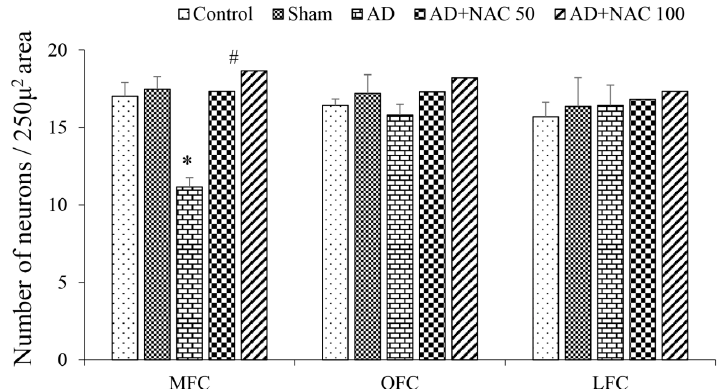
Figure 4. Quantitative estimation of normal neurons in prefrontal cortex. The number of neurons in 250 µ 2 area was quantified. Values are expressed as mean ± SE. Control/sham vs. AD: *, p < 0.01; AD vs. AD + NAC 50 or AD vs. AD + NAC 100: #, p < 0.01 (One-way ANOVA, Bonferroni’s multiple comparison test, n = 6 in all groups). MFC—Media prefrontal cortex, OFC—Orbital prefrontal cortex, LFC—Lateral prefrontal cortex.